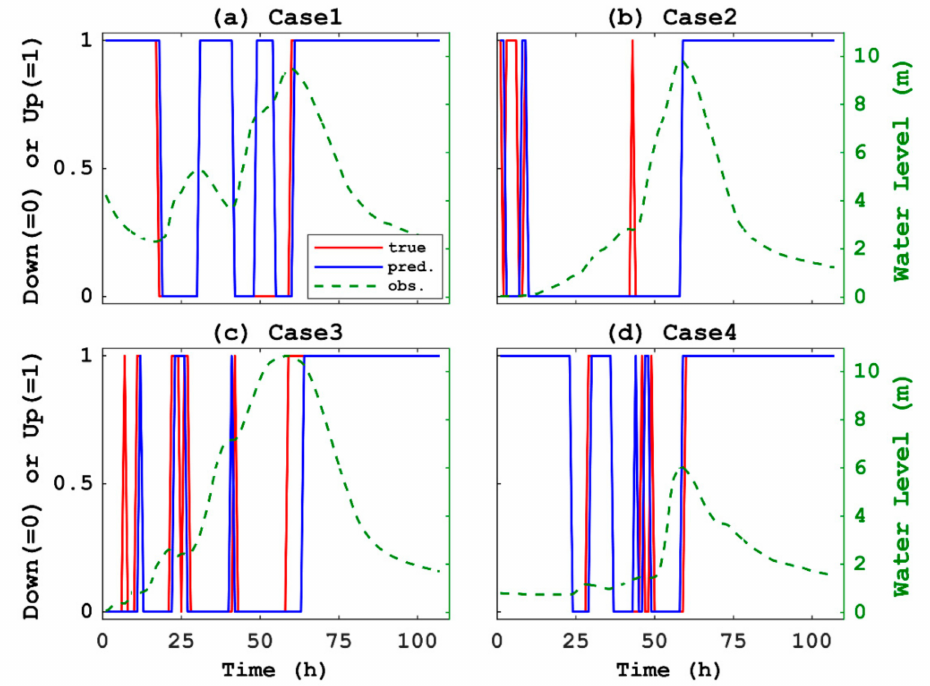
Figure A1. Comparisons between actual values (true) and predictions (pred.) in four cases in upward or downward trend of water level versus time. Green curves indicate observed water levels. The cases in Domain A correspond to ( a ) the third highest flood event, ( b ) the second highest flood event, ( c ) the highest flood event, and ( d ) the moderate peak flood